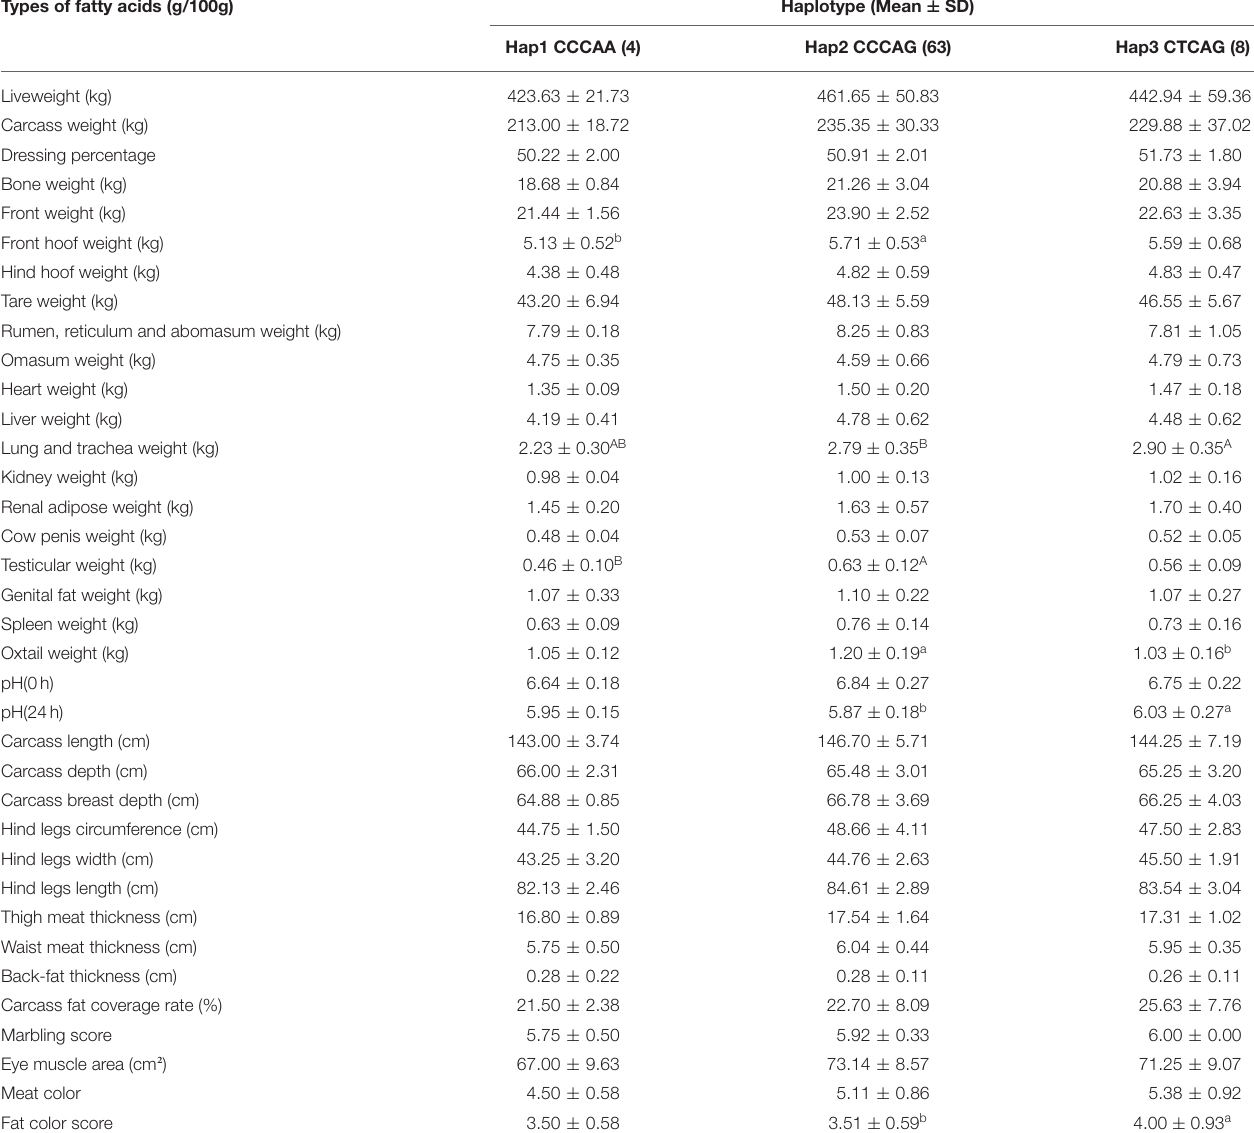
TABLE 4 | Association analysis of three haplotypes and economic traits in Chinese Simmental Cattle. Types of fatty acids